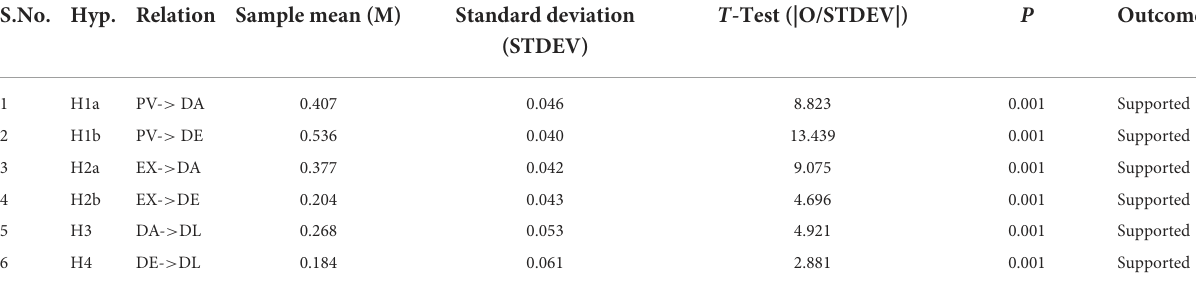
TABLE 4 Summary of structural path model results.